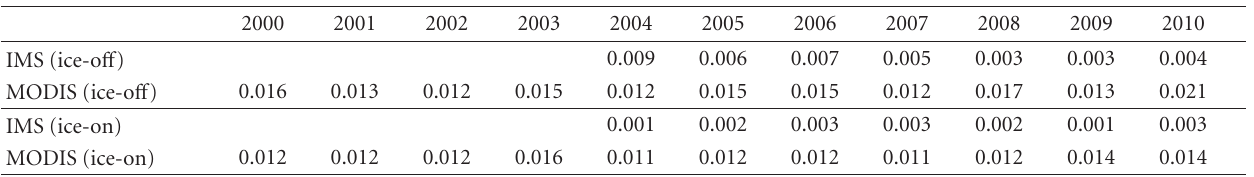
Table 5: Mean coe ffi cient of variation (CV) for all grid